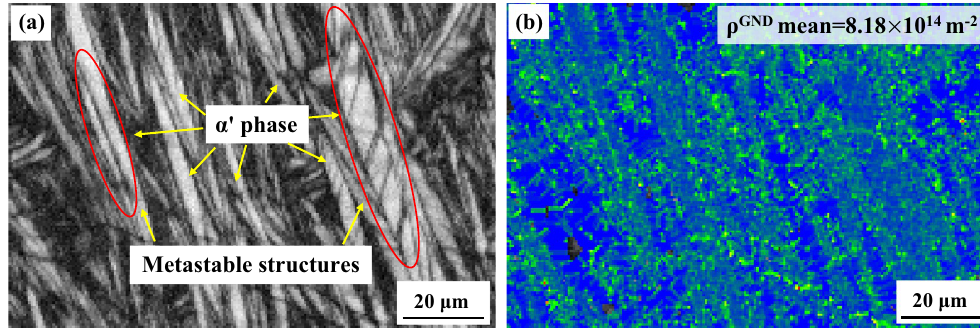
Figure 17 Typical EBSD image of LPBF track: a BC map, b GND